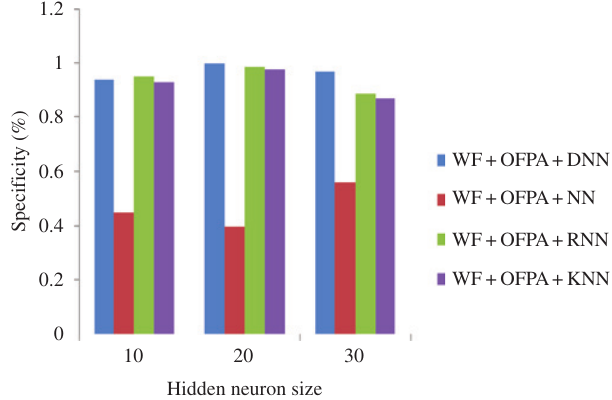
Figure 7: Performance of Proposed Approach Based on Specificity.